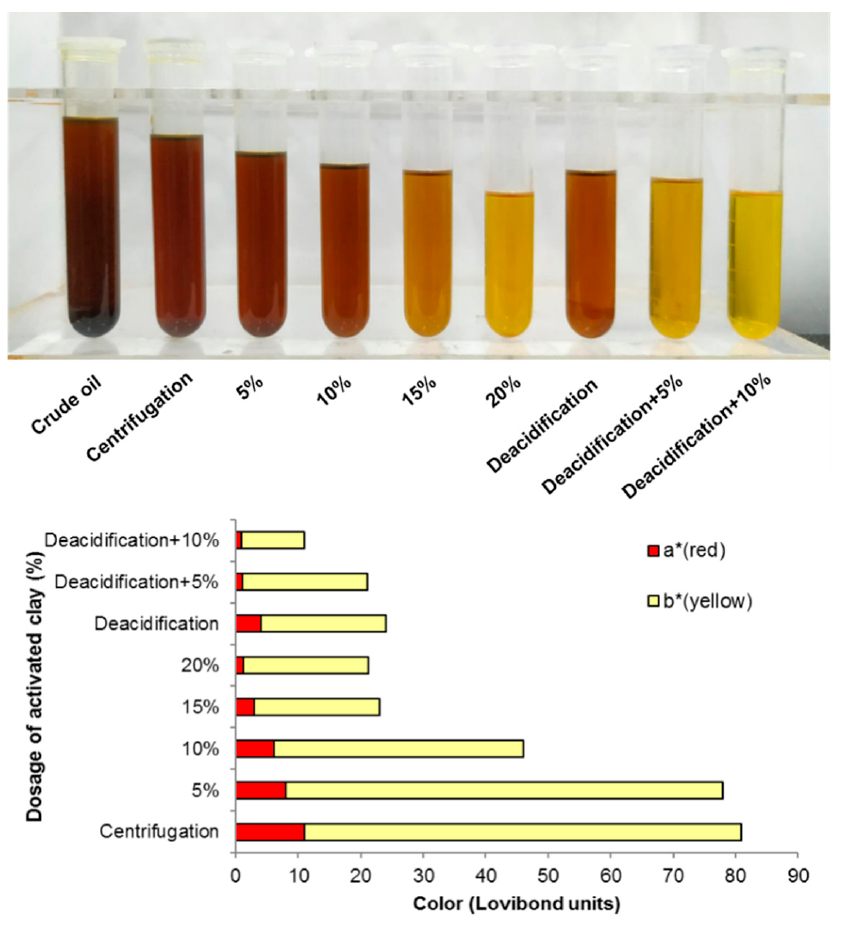
Figure 6. The decoloring effect of different refining methods on Litsea cubeba kernel oils.